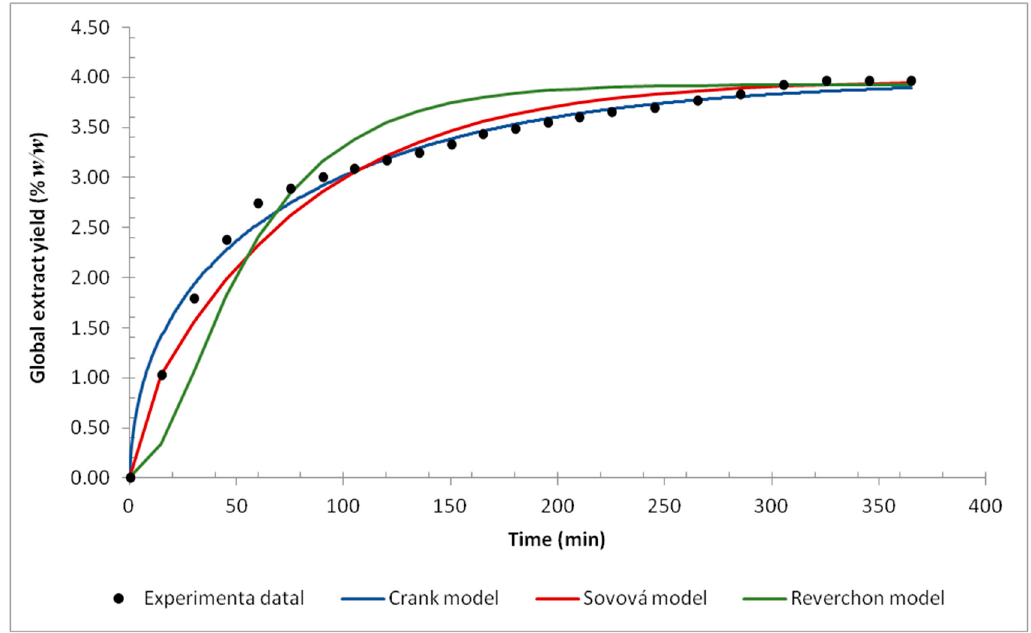
Figure 3. Process parameters optimized to maximum yield of p -anisic acid.